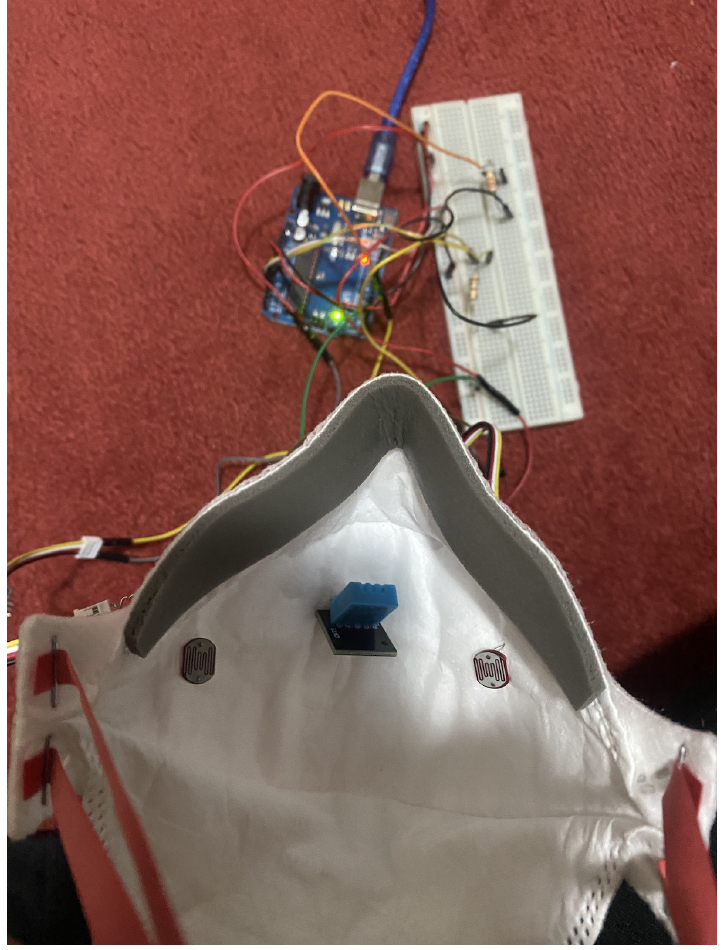
Figure 3. Set up of sensors inside the mask for Stage 1 process.